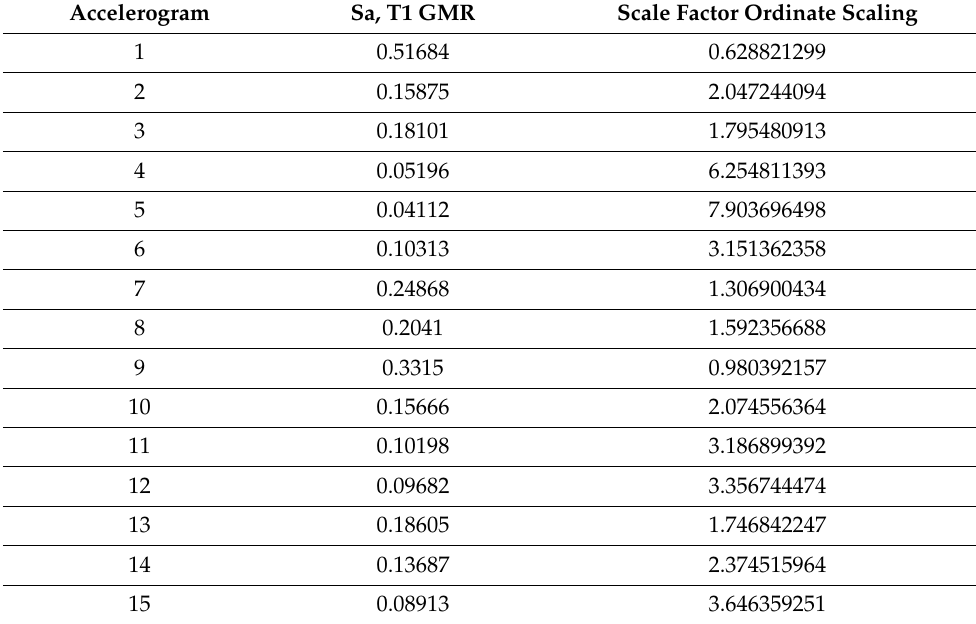
Table 2. Illustrations of the scaling factors.